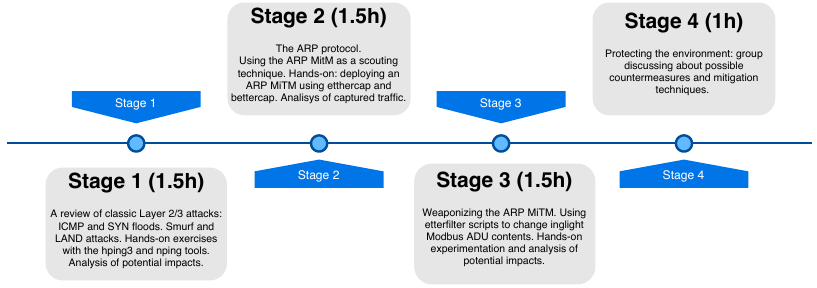
Figure 18. Organization of the third training module (5.5